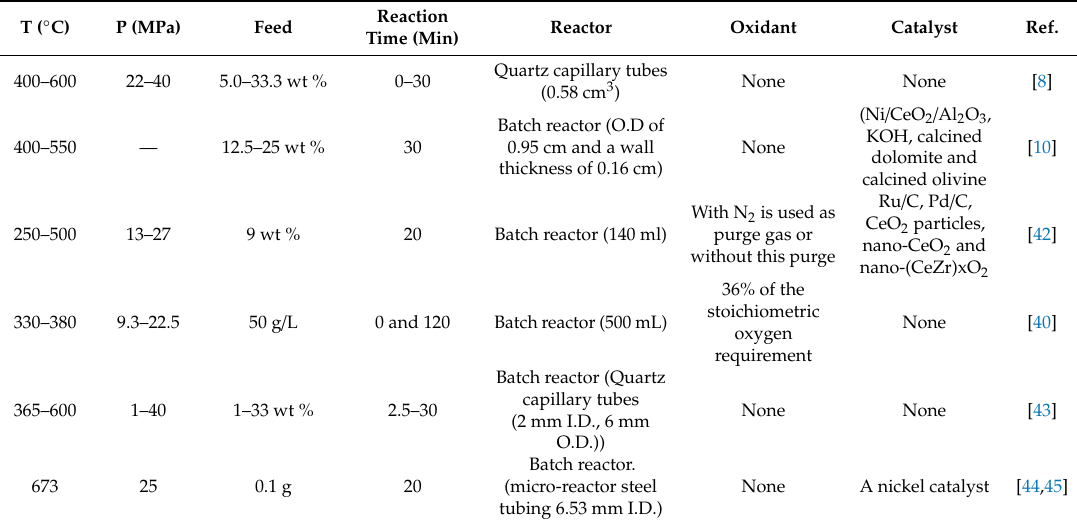
Table 1. Experimental studies of supercritical water gasification (SCWG) process using